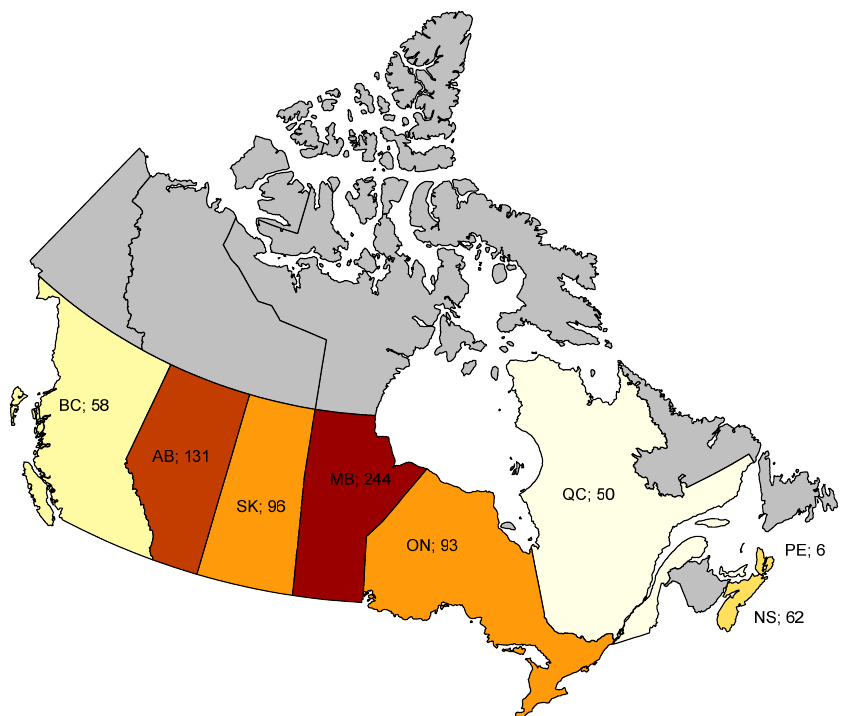
Figure 2. COVID-19 incidence by province. The figure shows the COVID-19 incidence for calendar week 20, 2021, for each Canadian province with more than five participants. Source: Public Health Agency of Canada (2021).